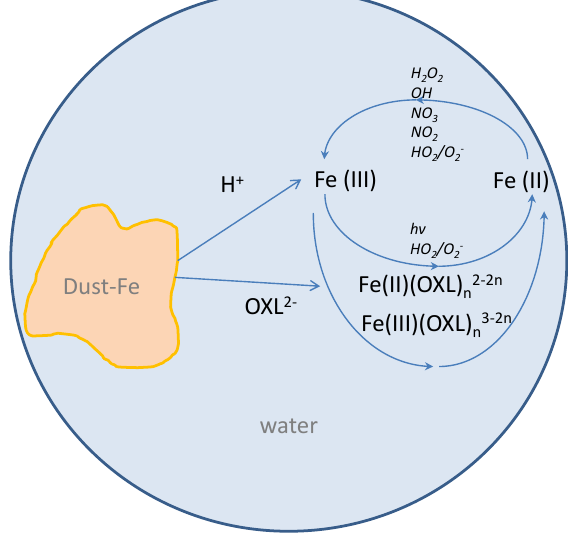
Figure 1. Atmospheric processing of dust-Fe taken into account in the model. Details on the chemical reactions are given in Table